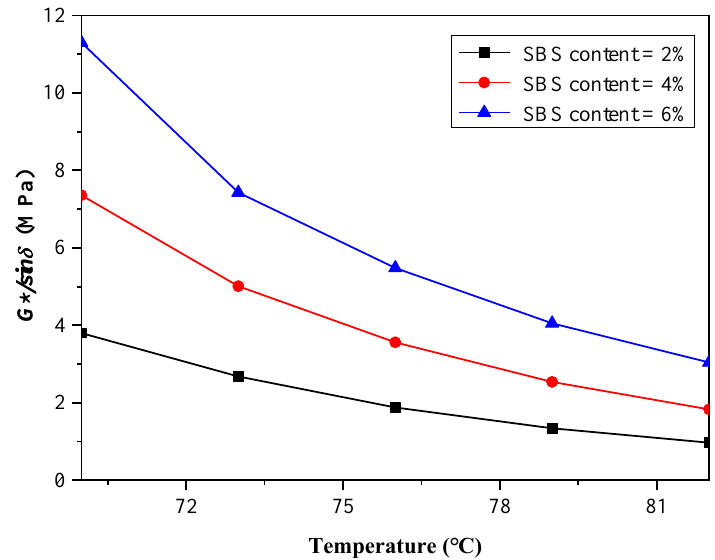
Figure 1. Curves of rutting factor with temperature under different SBS content.